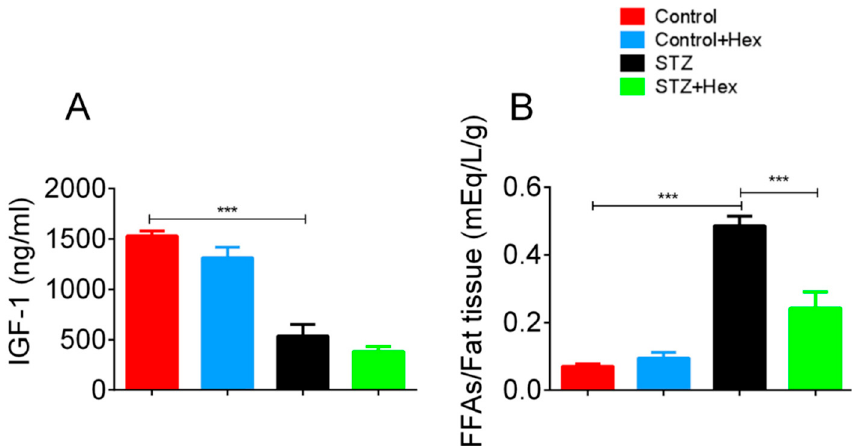
Figure 4. Circulating levels of IGF-1 and FFAs from control, control + Hex, STZ, and STZ + Hex rats. After the STZ or Hex treatment, terminal blood samples were collected. Circulating levels of ( A ) IGF-1 and ( B ) FFAs relative to fat tissue were determined by IGF-1 and FFAs ELISA kits. n = 6 from each group, data are shown as the mean ± SEM. *** p < 0.001.